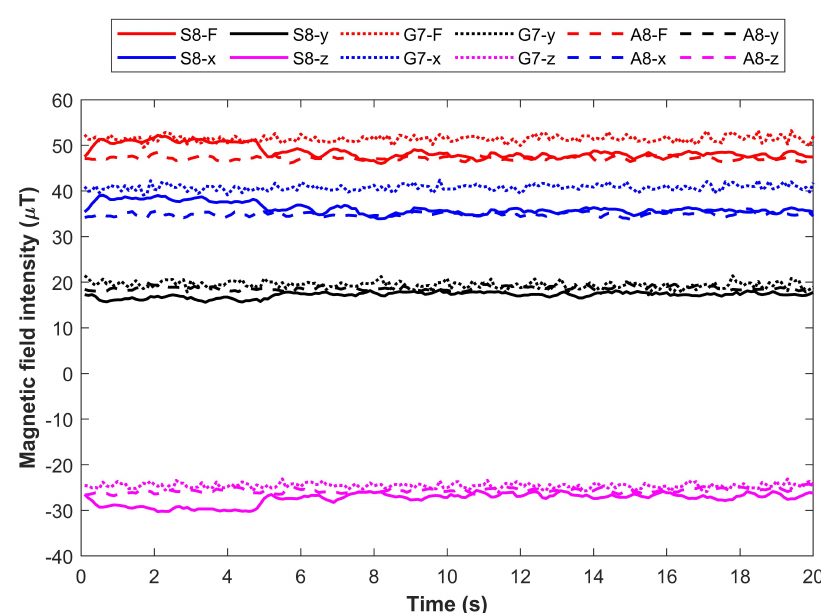
Figure 2. Magnetic field data from three different smartphones. Variation in the data can be seen for different devices. The variation may increase or decrease for other smartphones.